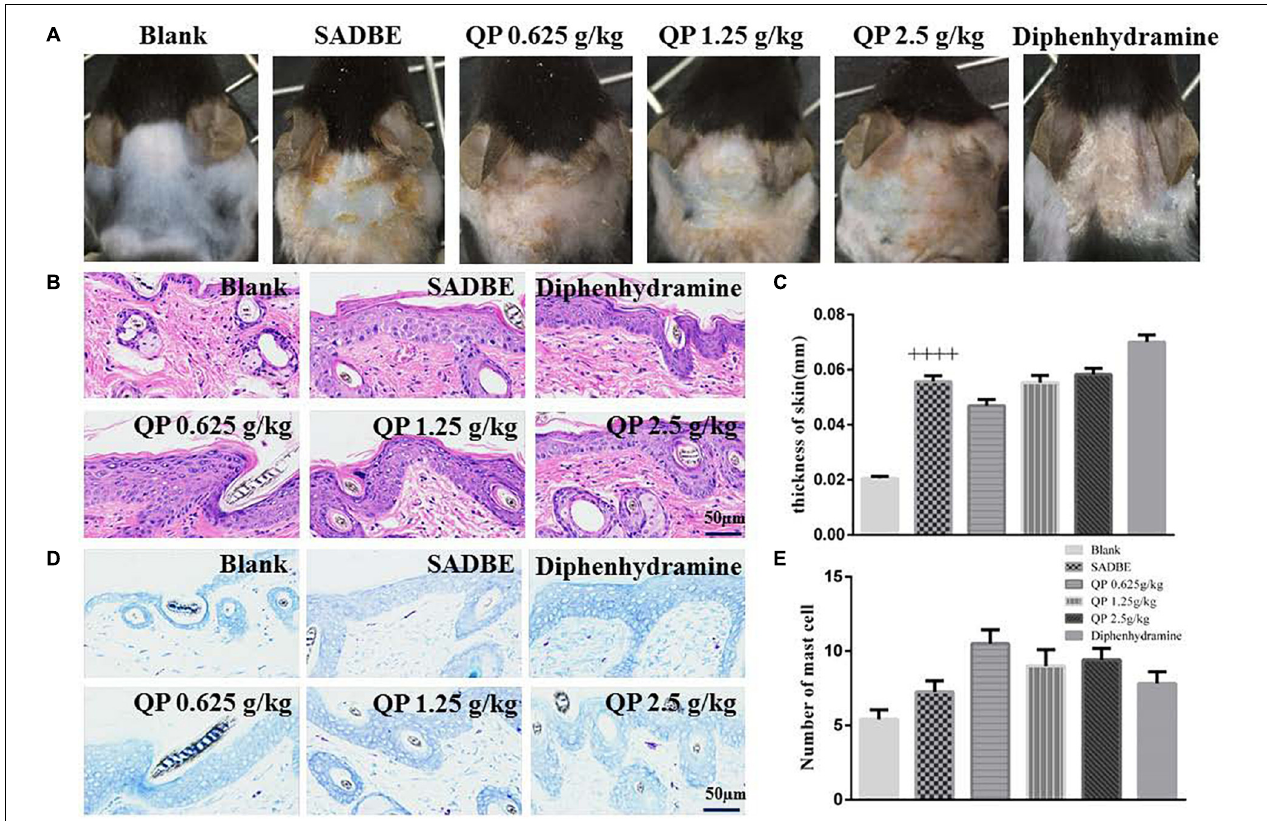
FIGURE 4 | Effect of QP on skin histological changes in SADBE mice. (A) The midline dorsal neck skin images of each group of mice were showed on day 13. The neck skin lesions in QP treatment groups were fewer than those in the model group. (B,C) showed representative HE staining images and measured skin thickness of each group as labeled, respectively. (D,E) showed representative toluidine blue images and cell counts of each group as labeled, respectively. Data was expressed as mean ± SEM. ++++ p < 0.0001, compared to the blank group. One-way ANOVA ( n = 5 each group). Scale bar: 50 µ